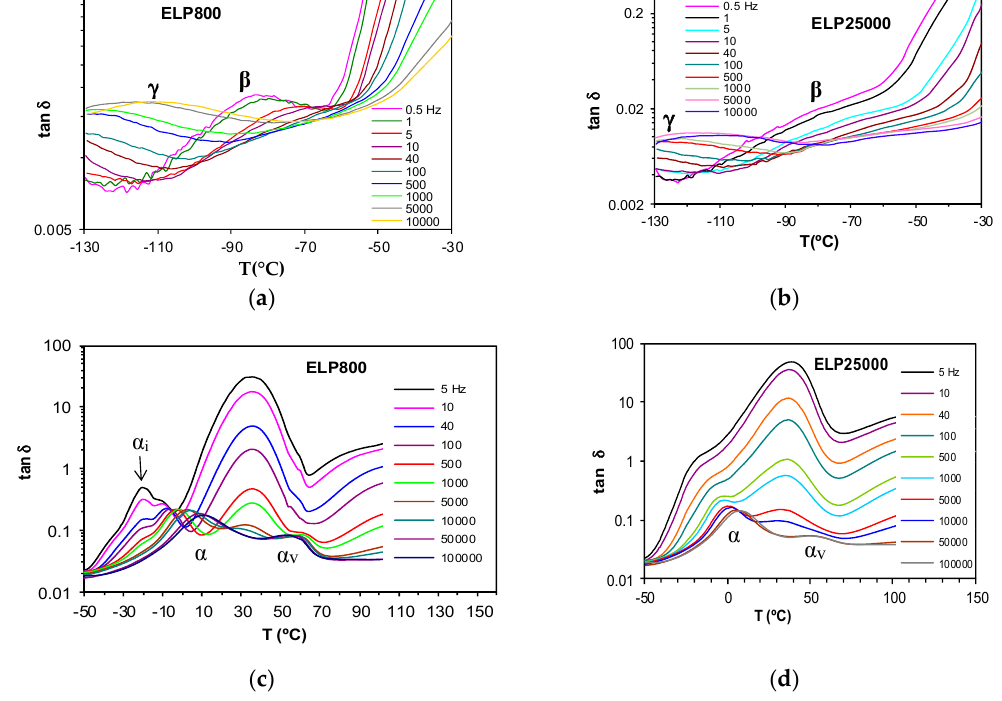
Figure 8. Dielectric relaxation curves for tan δ for the uncured ELP samples at 0.5 °C/min. Upper figures from − 130 °C to − 30 °C: ( a ) ELP800 and ( b ) ELP25000; lower figures from − 50 °C to 150 °C: ( c ) ELP800 and ( d ) ELP25000.